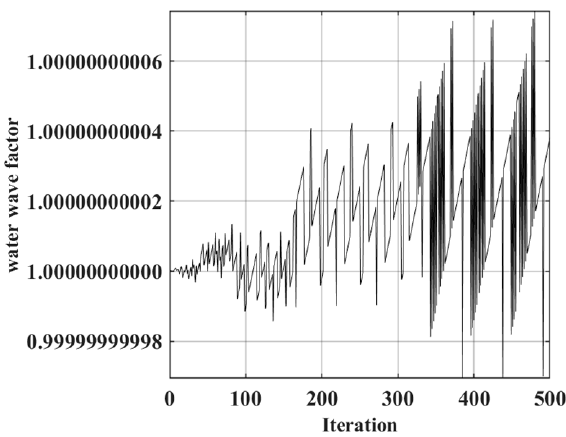
Figure 5. Adaptive water wave factor distribution with 500